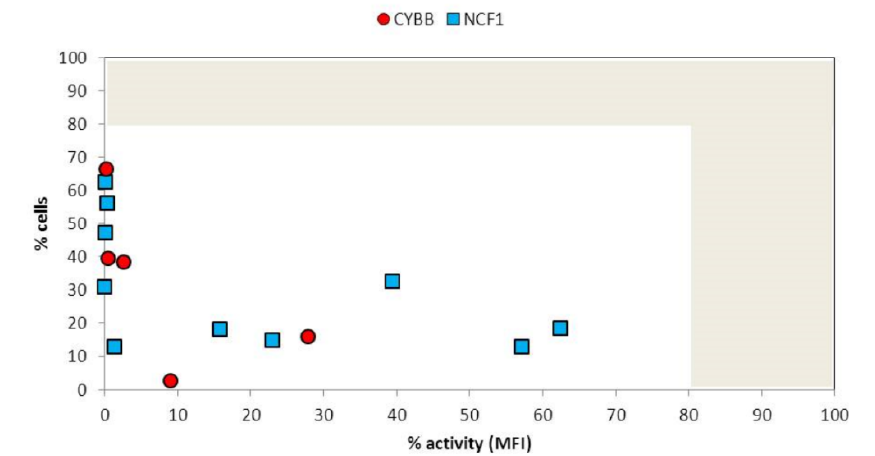
Figure 5. Nicotinamide adenine dinucleotide phosphate (NADPH) activity in individual patients with mutation CYBB (gp91phox) and NCF1 (gp47phox). Normal range depicted as grey area ( > 80% of cells demonstrating > 80% of activity in relation to healthy control.